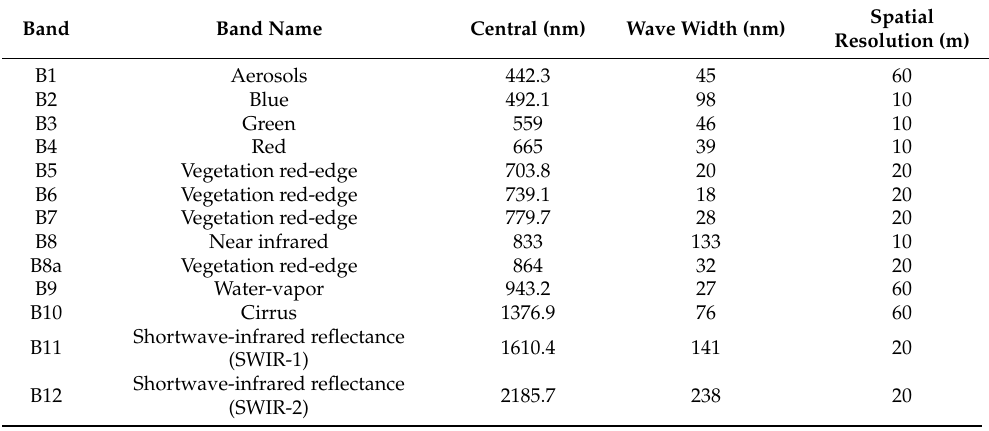
Table 1. The characteristics of Sentinel-2 imagery.